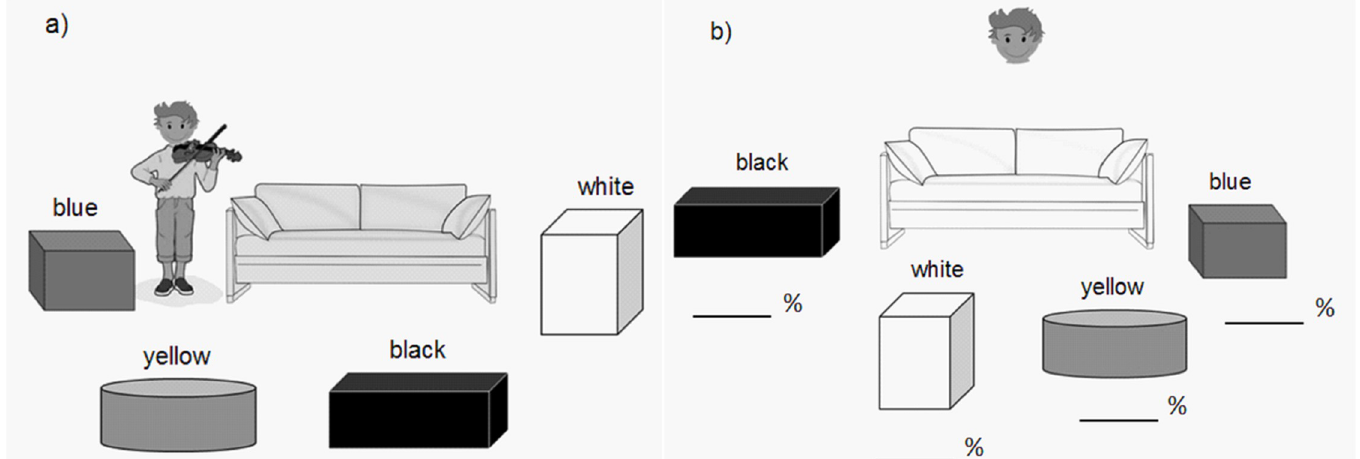
Fig 1. The first and last picture of the false-belief task. Pictures of the false-belief task show the set-up of the containers before the protagonist left the room (a) and after his return (b).